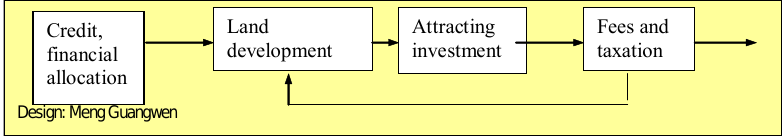
Fig. 2: The Model of Small-Scale Circulatory Land Development of Chinese FEZs